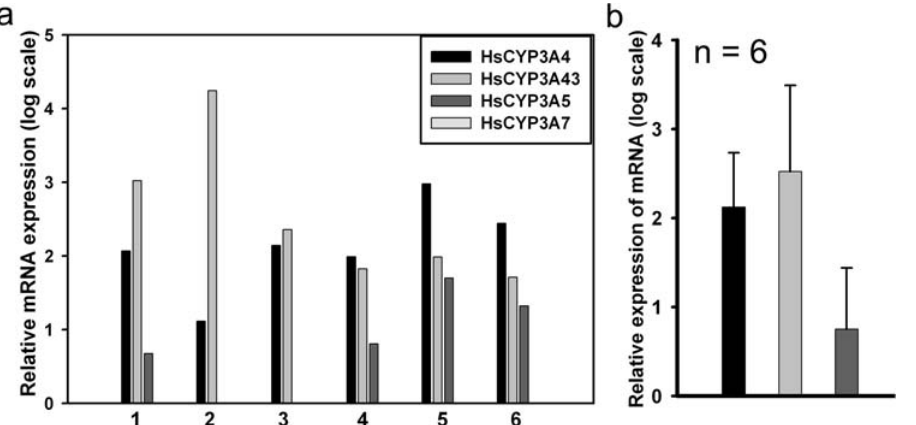
Figure 7. Relative expression of functional genes of CYP3A subfamily members in human brain samples. (a) The levels of CYP3A4, CYP3A5, CYP3A7, and CYP3A43 mRNA were quantified by qRT-PCR in the 6 human brain subjects. The expression of CYP3A5 was significantly lower then that of CYP3A4 and CYP3A43 and was detected only in four out of six samples. CYP3A7 was not detected in any of the subjects. (b) The average of the six samples analyzed.